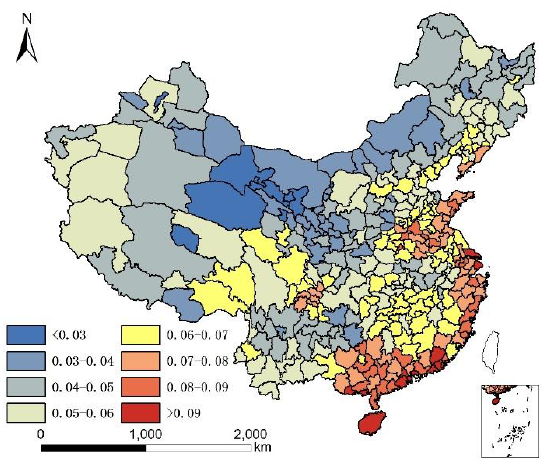
Figure 2. Longevity rate (85+/65+) in China in 2010.